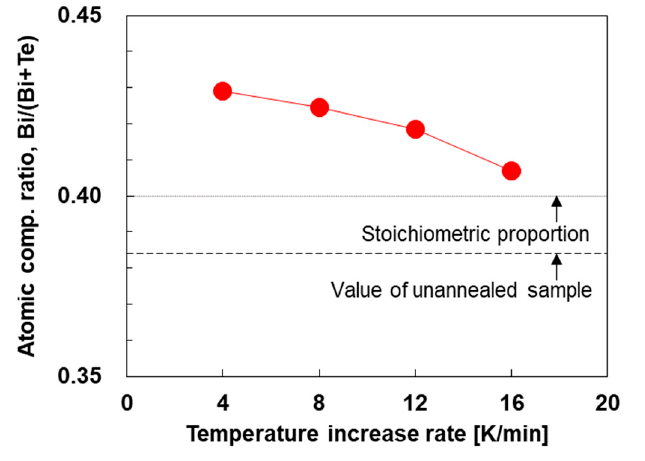
Figure 2. Atomic composition of the formed Bi 2 Te 3 thin films with different temperature increase rates determined from electron probe microanalyzer (EPMA).